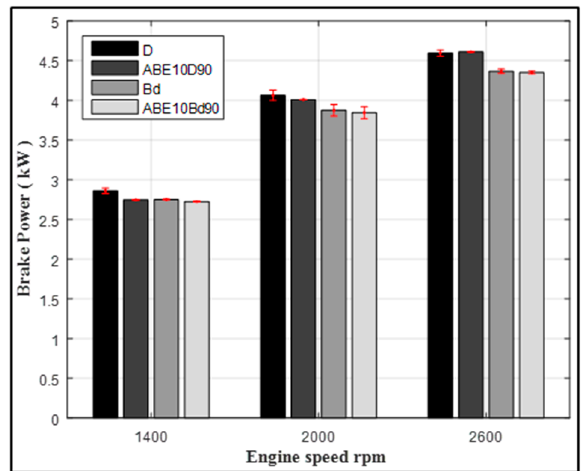
Figure 8. Brake power (BP) of test fuels.